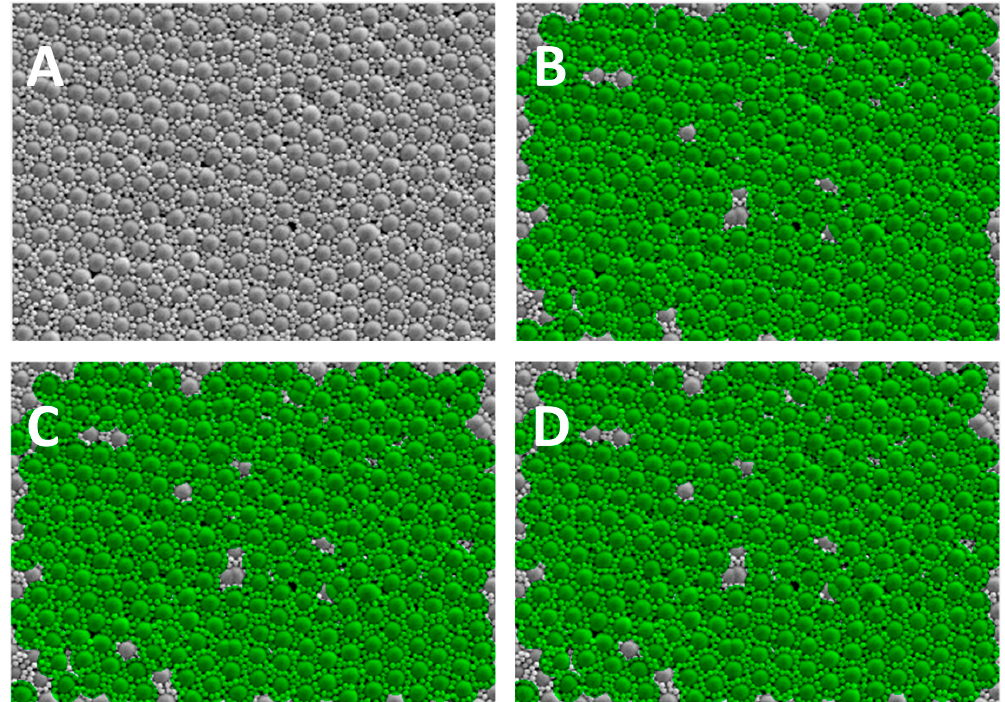
Figure 5. Selected SEM image of a 2 µm SiO 2 /0.51 µm PS-COOH BCC assembly. ( A ) shows the original image; ( B ) shows the image after processing where green areas represent a combination of highly uniform, partially uniform and disordered areas (92%); ( C ) partially and highly uniform areas (90%) and ( D ) highly uniform areas (90%).